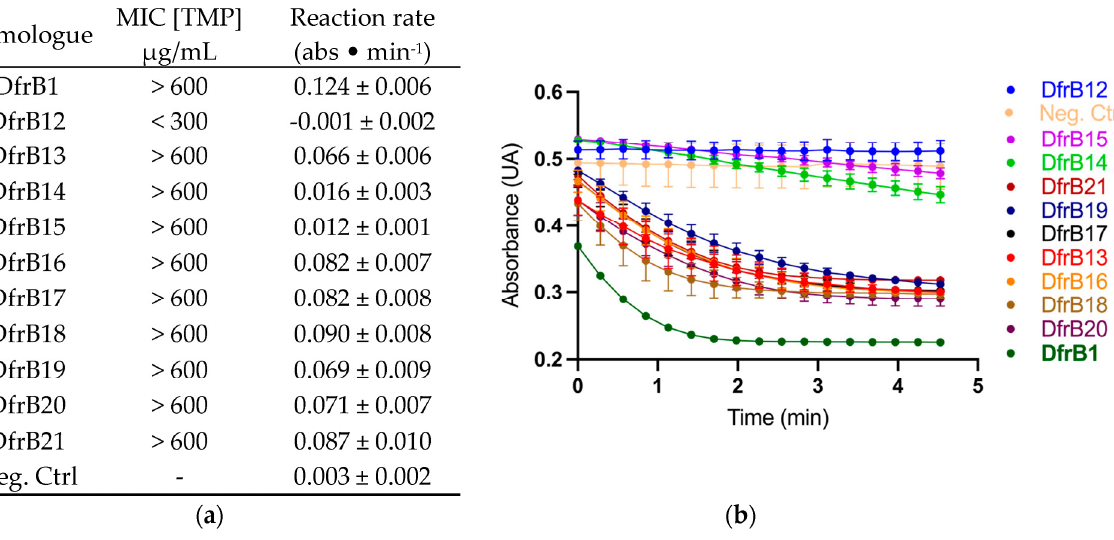
Figure 2. Newly identified DfrB homologues confer TMP resistance and possess Dfr activity. ( a ) Minimal inhibitory concentrations were determined on solid media with [TMP] ranging between 0–600 µg/mL. The reported MIC was the lowest TMP concentration where no bacterial growth was observed. The initial rates of reaction were calculated from panel B ( n = 3, mean ± SD). The rate of the most active variants is underestimated, since the initial rate was not captured. ( b ) Dfr activity was determined in E. coli lysate, monitoring substrate consumption as a function of time ( n = 3, mean ± SD). The negative control (Neg. Ctrl) is E. coli expressing the cTEM-19m β -lactamase instead of a DfrB.